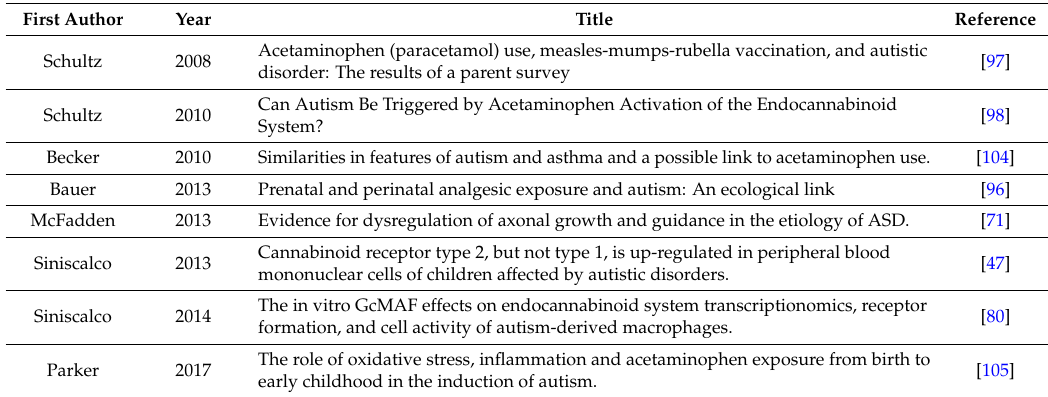
Table 1. PubMed analysis of current literature limited to keywords “EC system disruption human